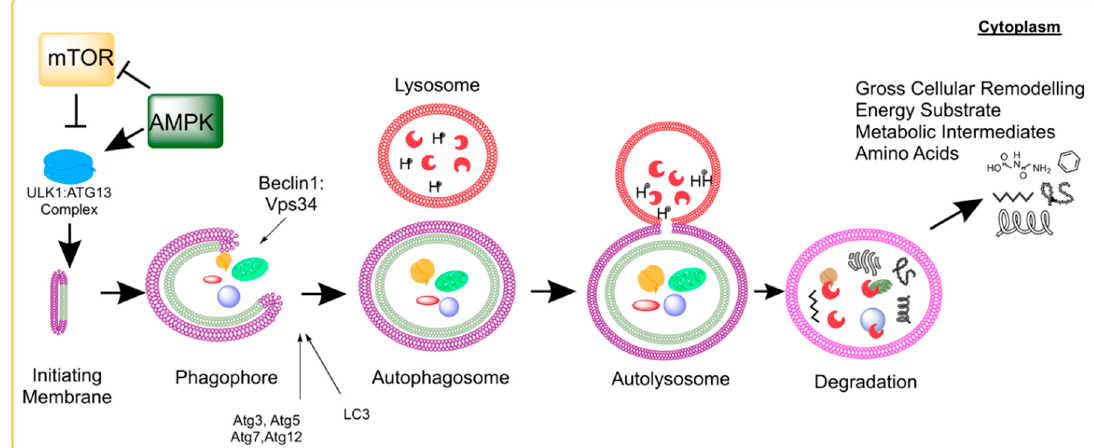
Figure 1. Molecular Events of Autophagy and related Signaling Pathways. Autophagy is a highly-conserved cellular process across eukaryotes from yeast to human. The initiation membrane matures and develops into a phagophore around cytoplasmic compartments containing a variety of macromolecules, organelles, and other cytoplasmic contents. Once fully enclosed, the autophagosome will fuse with the lysosome exposing the contents of the autophagosome to an acidic pH and various digestive enzymes of the lysosome. Following degradation of the contents of the autolysosome, the resulting molecules become available for cytoplasmic utilization (including amino acids, carbon fuel substrates, nucleotides, and reducing cofactors). This process simultaneously allows the cell to undergo drastic and rapid remodeling. Previous research has specifically shown the interaction of mTOR and AMPK in the initial steps of the autophagy process through phosphorylation interaction with the ULK1:Atg13:FIP200 complex.